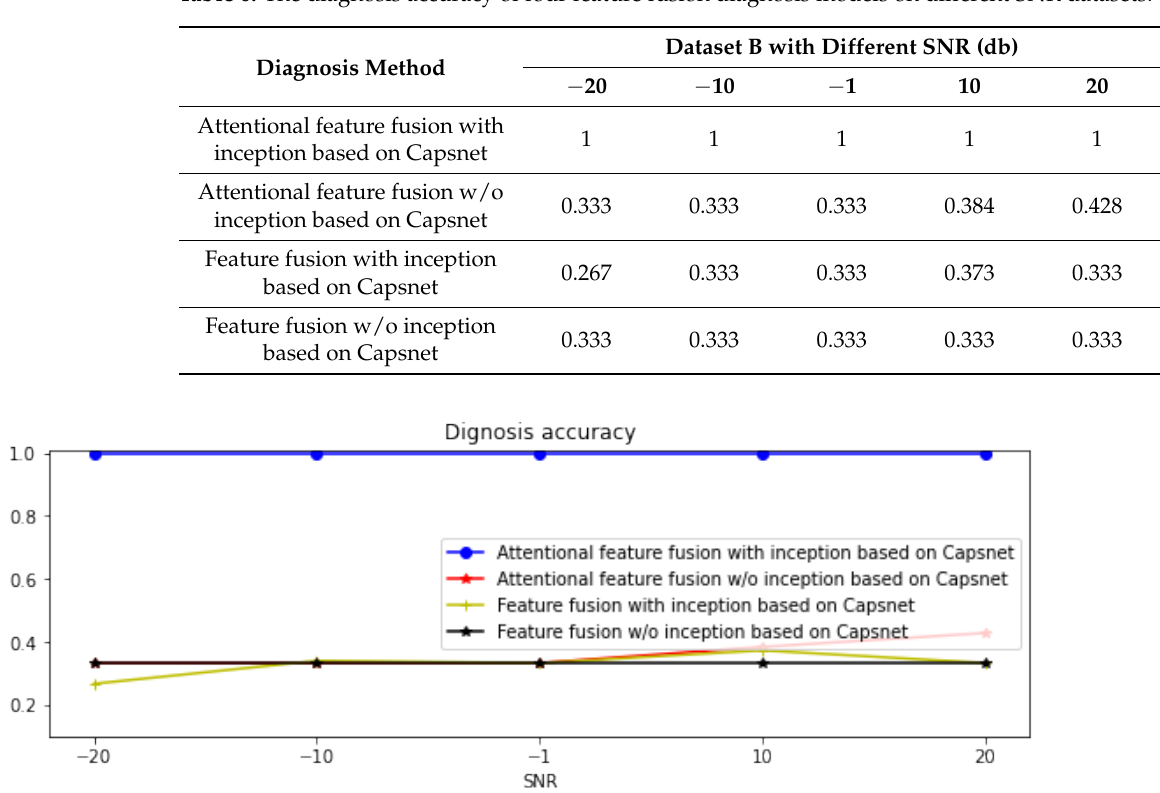
Table 6. The diagnosis accuracy of four feature fusion diagnosis models on different SNR datasets.